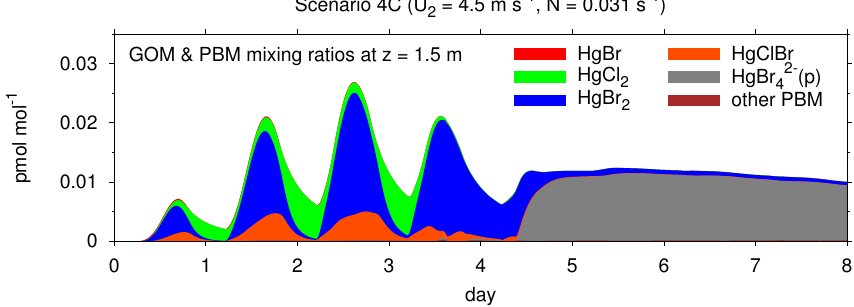
Fig. 11. Speciation of GOM and PBM at z = 1 . 5m in ambient air above the snowpack as simulated with scenario 4C at U 2 = 4 . 5ms − 1 . Because of very low mixing ratios simulated, GOM species other than HgBr 2 , HgCl 2 , HgClBr and HgBr are neglected in this plot.